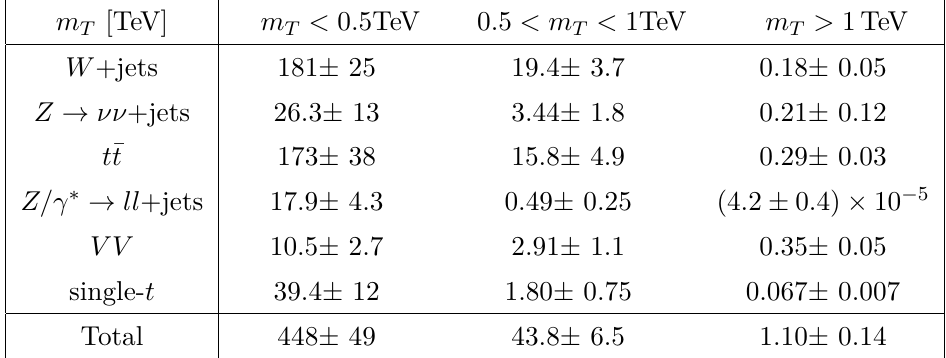
Table 2 . Our estimate for SM background number of events in pp → τν + b at integrated luminosity of 35.9 fb − 1 . The systematic uncertainty in table was obtained by rescaling each uncertainty in the CMS analysis (see table 1) with the ratio of events between the two analyses.